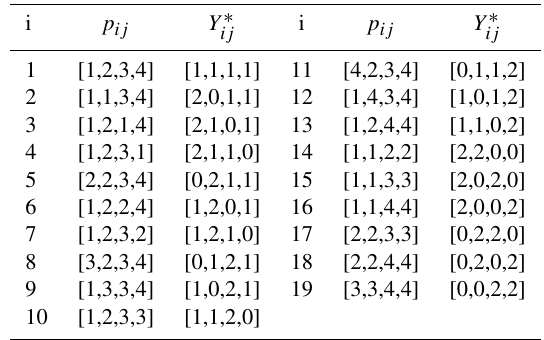
Table 1. Bootstrap selections.